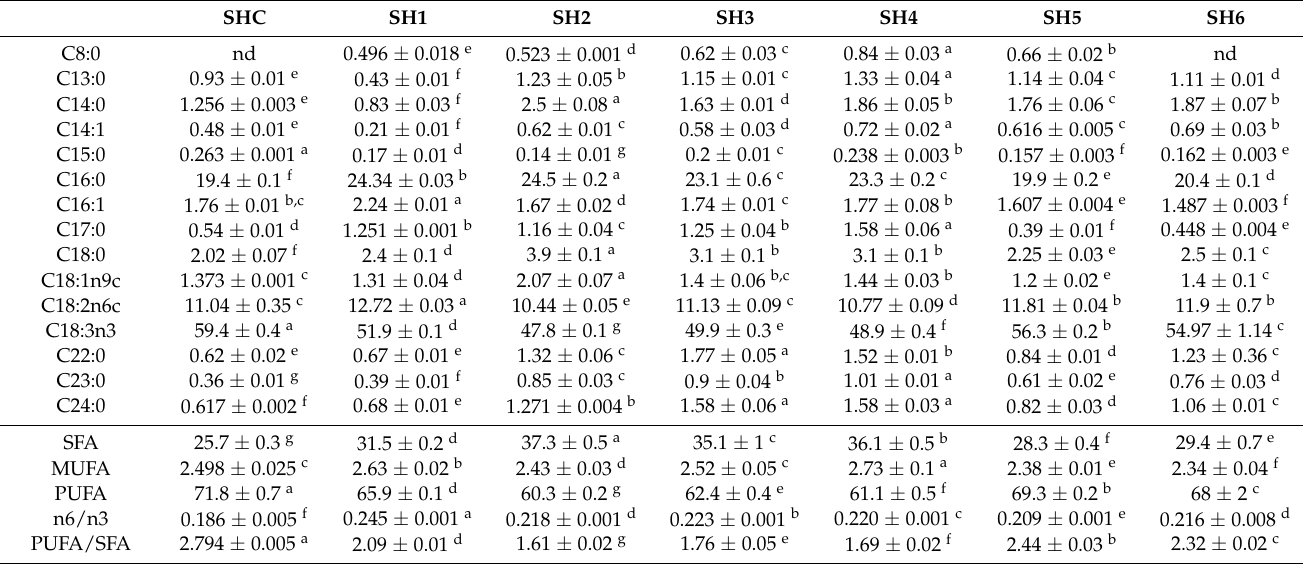
Table 7. Fatty acid composition (relative percentage %) in S. hispanicus leaves in relation to fertigation regime (mean ±